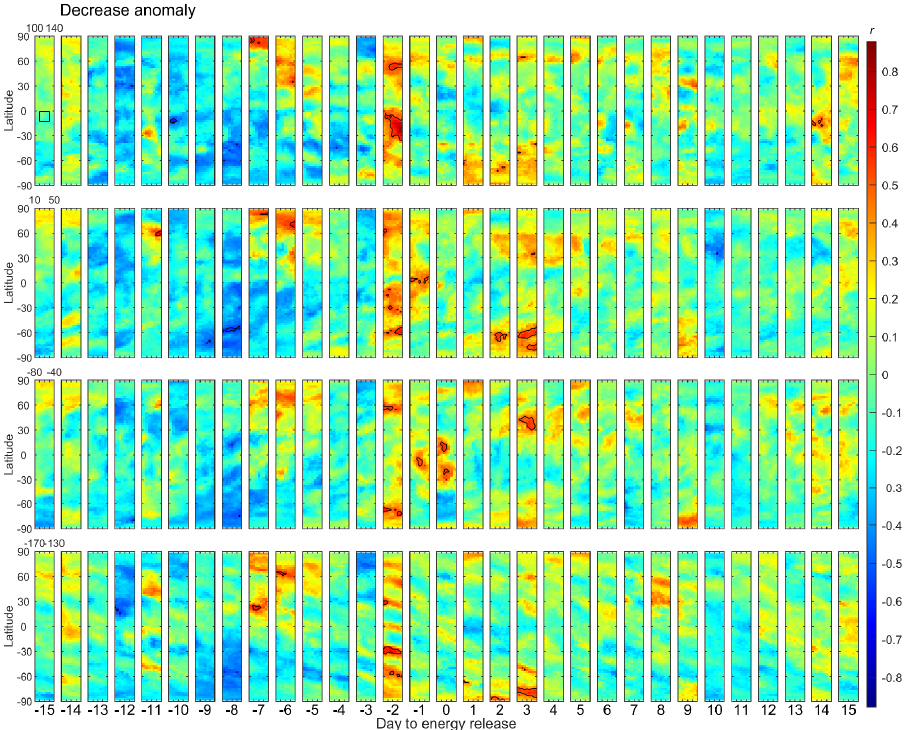
Figure 12. Same as Figure 11, but data are removed using Kp and F10.7.